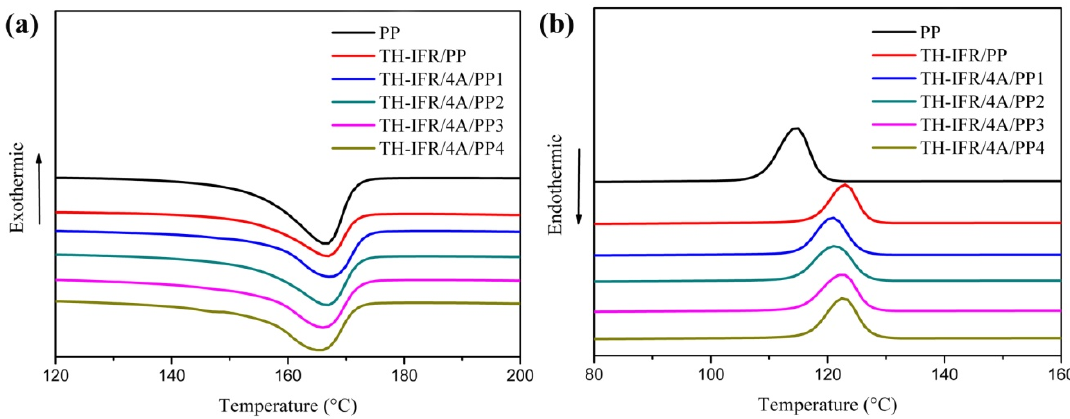
Figure 6. The DSC melting ( a ) and crystallization ( b ) curves of pure PP and FR PP composites. Table 4. The DSC parameters of pure PP and FR PP composites. Table 4. The DSC parameters of pure PP and FR PP composites.